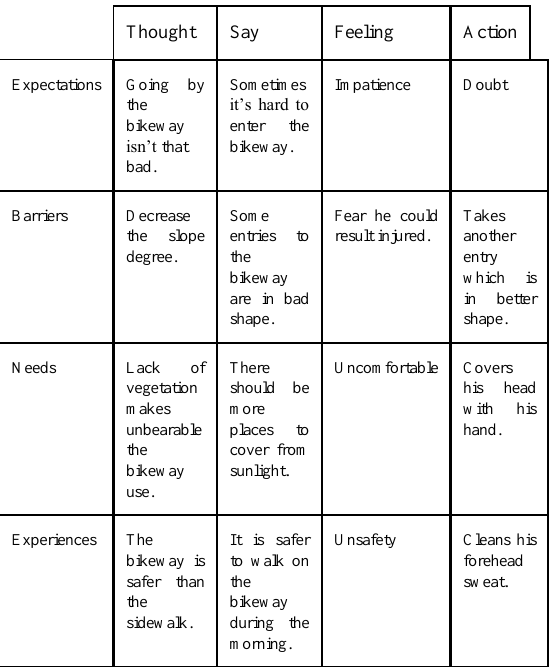
Table 1. Example of qualitative variables data